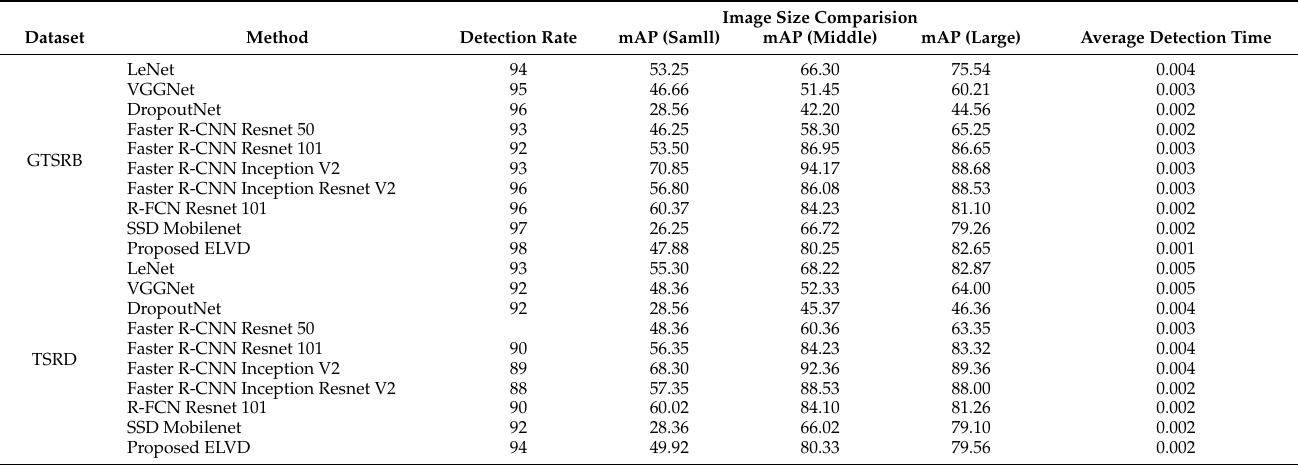
Table 8. Comparative analysis with other Existing